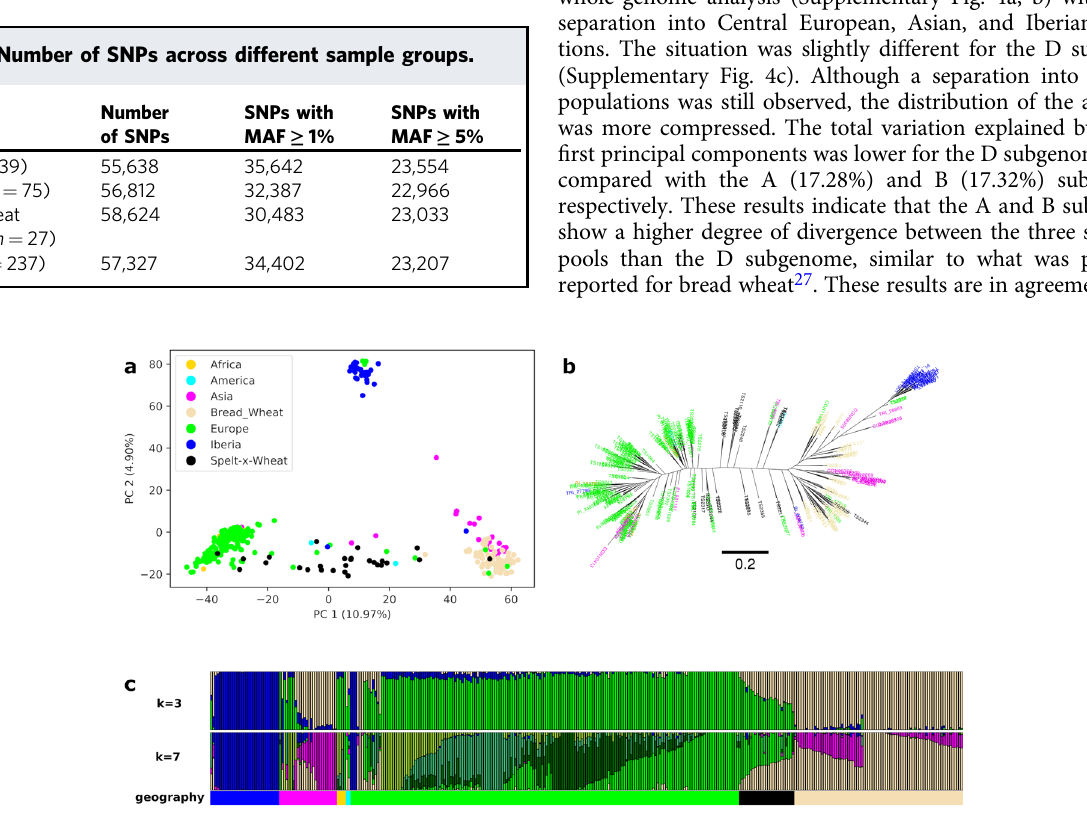
Fig. 2 Whole-genome analysis of spelt and bread wheat. a Principal component analysis (PCA) across the 339 spelt and bread wheat accessions. Samples are colored according to subspecies and geographical origin. b Maximum-likelihood tree constructed with SNPhylo. The colors used to label the accessions are identical to a and the branch size is indicated below the tree. c ADMIXTURE ancestry coef fi cients ( K = 3 and K = 7) for the 339 accessions of spelt and bread wheat. Stacked bars represent accessions and colors represent ancestry components. Accessions are ordered according to subspecies and geographic